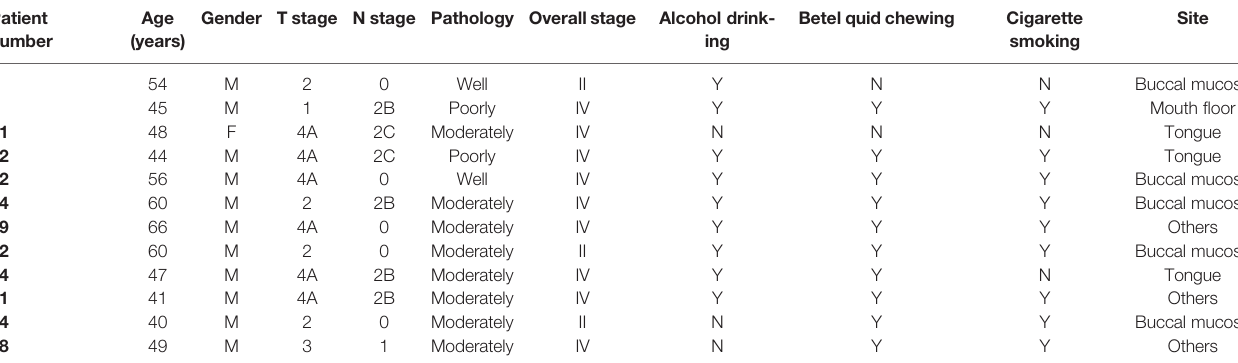
TABLE 2 | The clinicopathological characteristics of 12 OSCC PDX